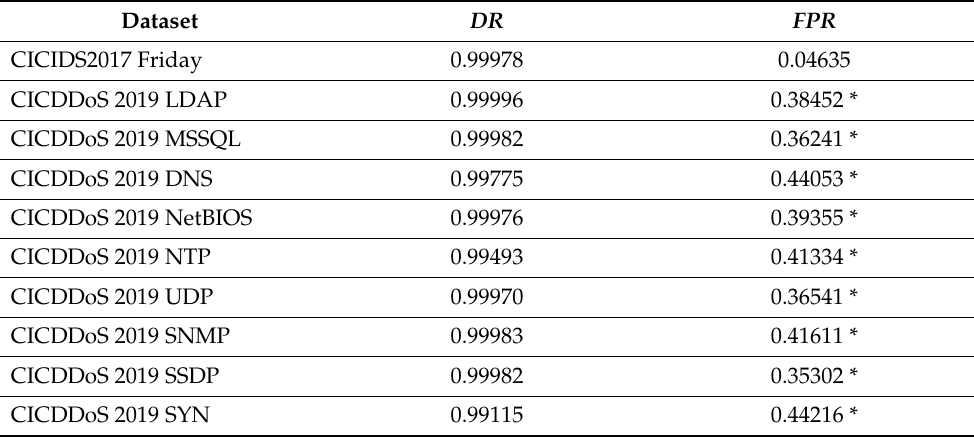
Table 8. Unknown attack detection